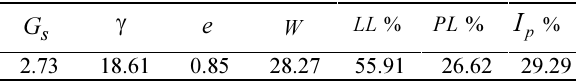
Table 4. Characteristic properties of Grindsted